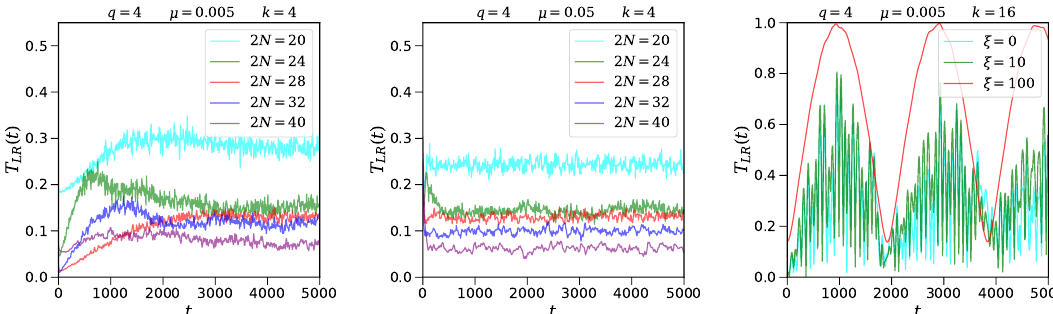
Figure 10. Transmission amplitude T LR at zero temperature for fixed sparsity parameter k = 4 and different values of N , averaged over 50 disorder realizations, for (a) µ = 0 . 005 and (b) µ = 0 . 05 . (c) Single realization of the transmission amplitude T LR for low-energy states with 2 N = 32 and sparsity parameter k = 16